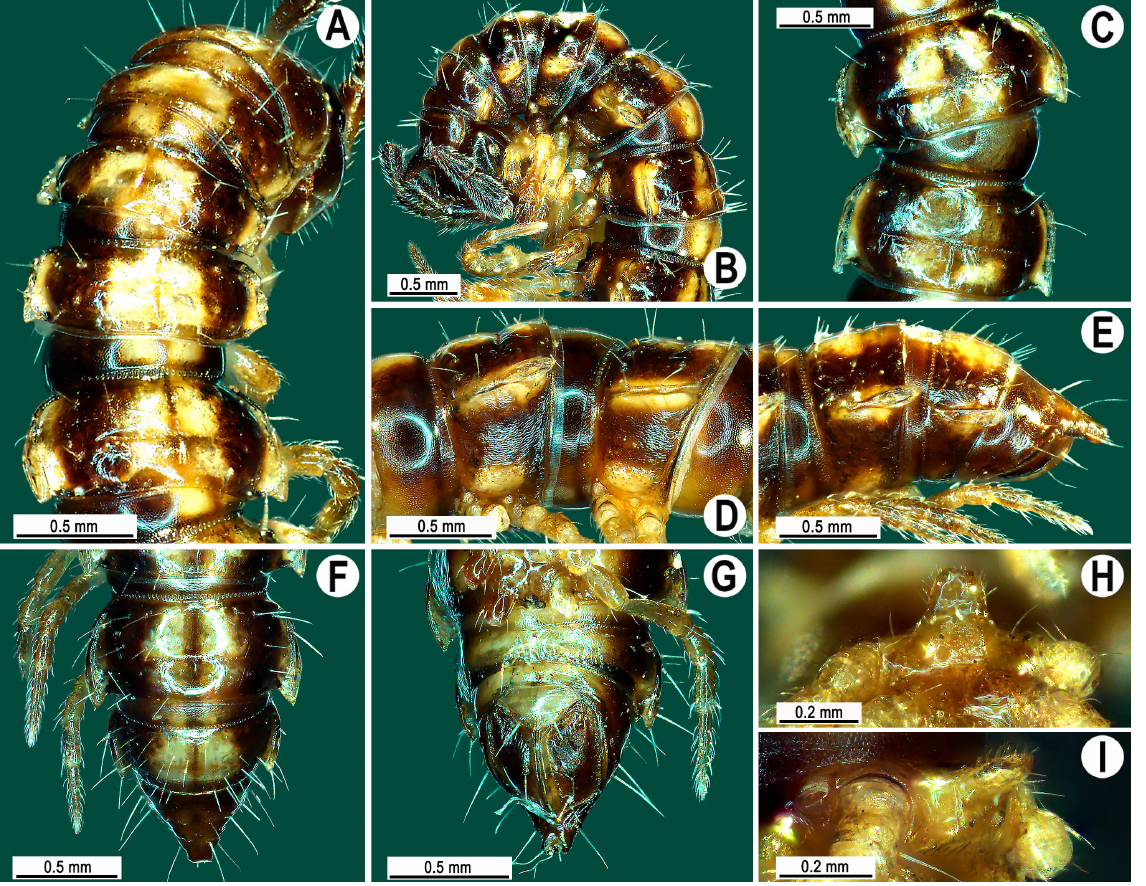
Fig. 1. Tylopus flavolineatus sp. nov., holotype, ♂ ( A, C–I ), paratype, ♂ ( B ). A–B . anterior part of body, dorsal and lateral views, respectively. C–D . Segments 10 and 11, dorsal and lateral views, respectively. E–G . Posterior part of body, lateral, dorsal and subventral views, respectively. H–I . Sternal cones between coxae 4, caudal and sublateral views,